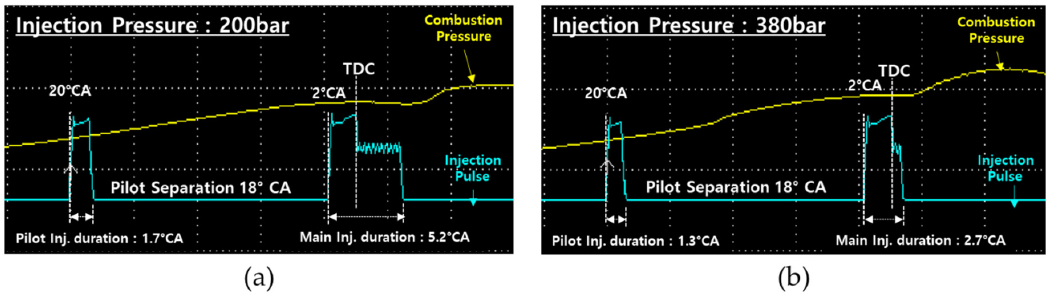
Figure 2. Injection timings and duration of pilot and main. ( a ) Injection Pressure 200 bar and ( b ) injection pressure 380 bar.